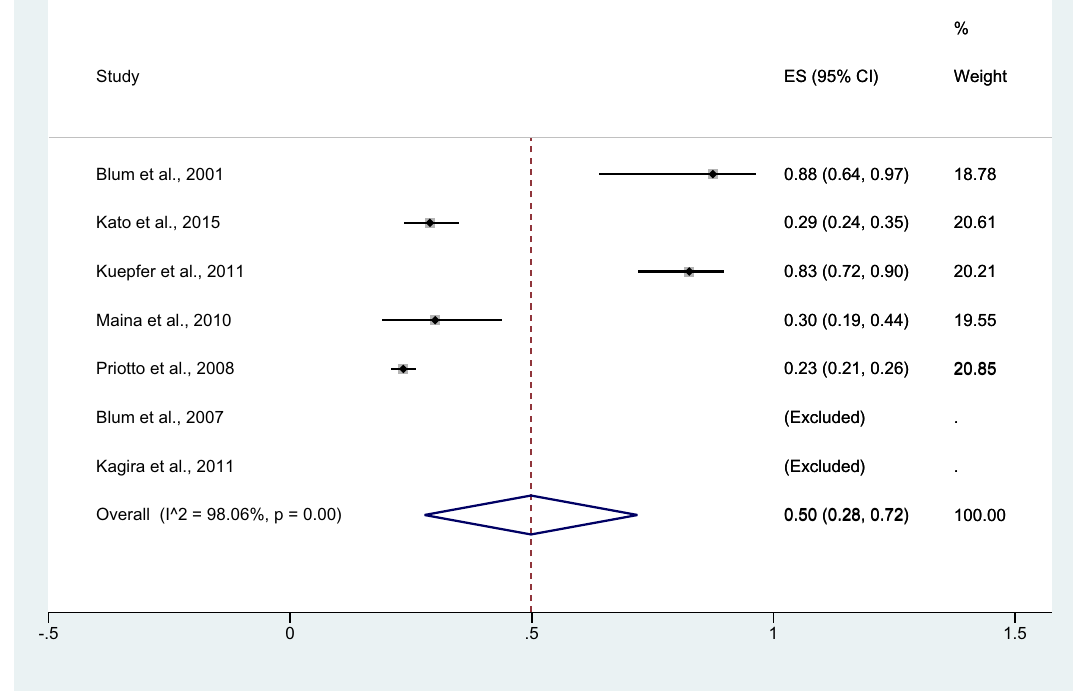
Figure 3. Pooled prevalence of malaria in human African trypanosomiasis. ES effect size, CI confidence interval; black diamond symbol, point estimate, Dashed line: pooled prevalence of malaria in human African trypanosomiasis; I 2 , level of heterogeneity; p = 0.00 or less than 0.05, significant